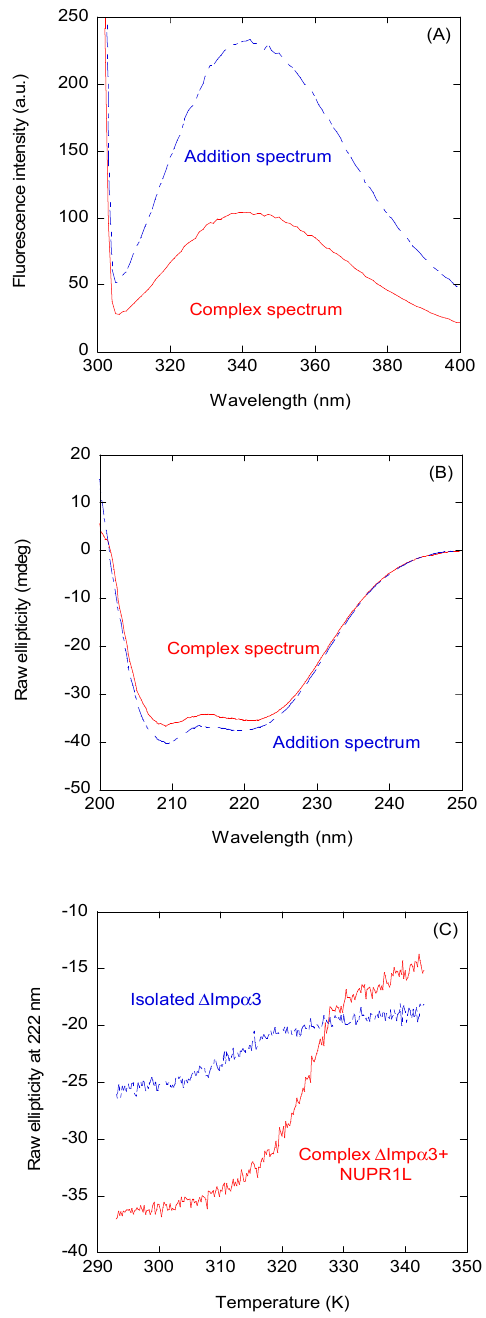
Figure 1. Binding of intact nuclear protein 1 NUPR1L to ∆ Imp α 3 monitored by spectroscopic techniques: ( A ) Fluorescence spectrum obtained by excitation at 295 nm of the complex between ∆ Imp α 3 and intact NUPR1L, and addition spectrum obtained by the sum of the spectra of both isolated macromolecules. ( B ) Far-UV circular dichroism (CD) spectrum of the complex between ∆ Imp α 3 and NUPR1L and the addition spectrum obtained by the sum of the spectra of both isolated macromolecules. ( C ) Thermal denaturations of ∆ Imp α 3 in the presence and absence of NUPR1L followed by the changes in ellipticity at 222 nm. All experiments were carried out in phosphate buffer (50 mM, pH 7.0).